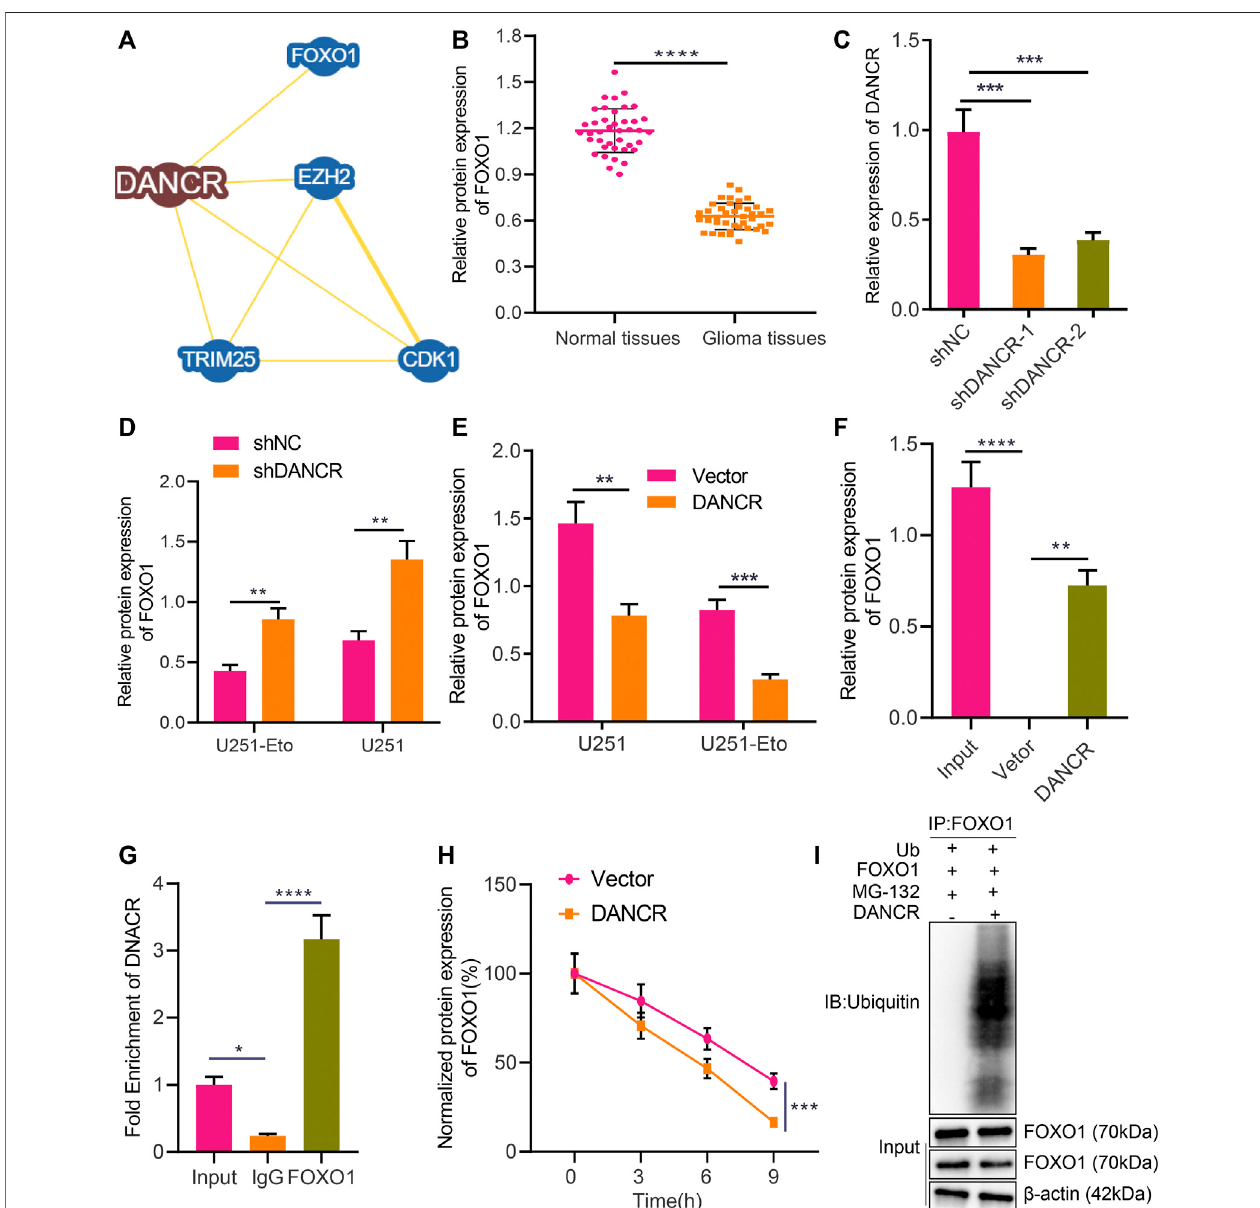
FIGURE 4 | DANCR promotes FOXO1 ubiquitination and degradation in glioma cells. (A) Interaction factors of DANCR predicted by the BioGRID website. (B) Western blot analysis of FOXO1 protein in glioma tissues and normal brain tissues. (C) RT-qPCR analysis of ef fi ciency of DANCR silencing in U251 cells upon treatment with sh-DANCR-1 or sh-DANCR-2. (D) RT-qPCR analysis of FOXO1 mRNA expression in U251 cells and U251-Eto upon treatment with sh-NC, or sh-DANCR. (E) WesternblotanalysisofFOXO1proteininU251cellsandU251-Etoupontreatmentwithsh-NC,orsh-DANCR. (F) BindingbetweenFOXO1andDANCRanalyzed by RNA pull-down assay in U251 cells. (G) Binding between FOXO1 and DANCR con fi rmed by RIP assay. (H) Western blot analysis of FOXO1 protein upon treatment with CHX and transduction with DANCR or vector at 0, 3, 6, 9 h after administration. (I) Ubiquitination experiment of FOXO1 protein ubiquitination upon treatment with Ub, DANCR, or FOXO1. * p < 0.05, ** p < 0.01, *** p < 0.001, **** p < 0.0001. Values shown represent mean ± standard deviation of three independently performed experiments. The unpaired t test was used for the comparison between data of two groups. Multigroup data comparison was conducted by one-way ANOVA followed by Tukey post hoc test. Data among groups at different time point were compared by two-way ANOVA, followed by Tukey post hoc test.